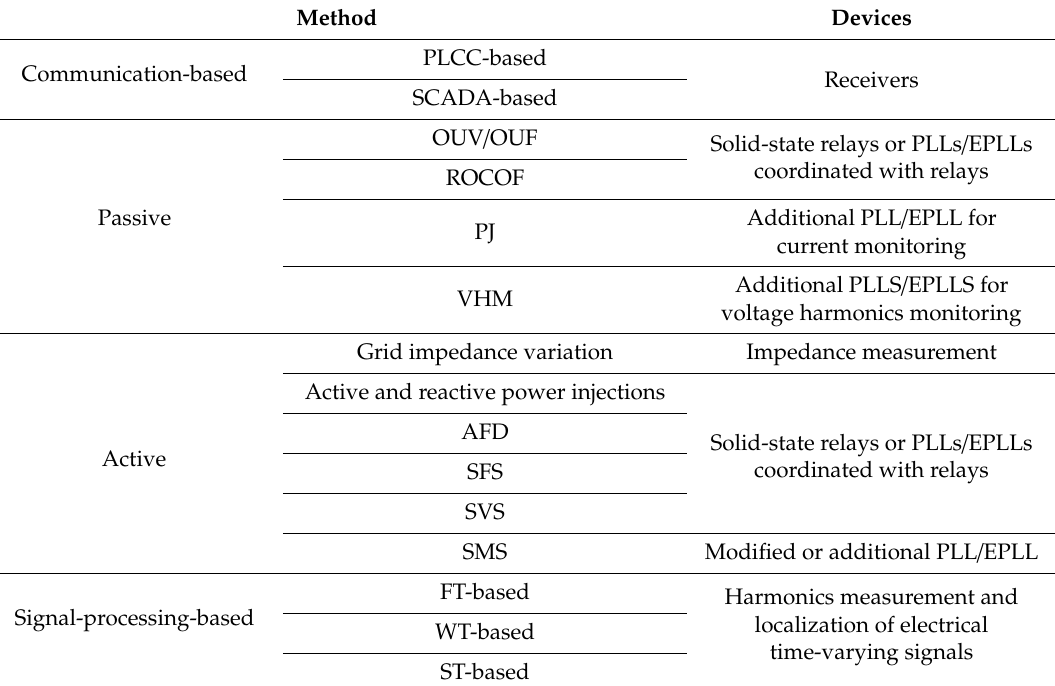
Table 3. Main devices of the islanding detection